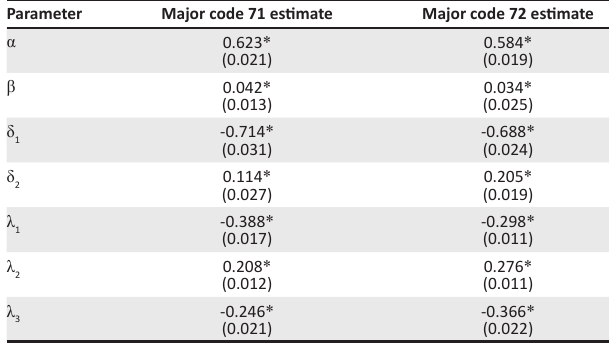
TABLE 3: Estimation results of the additive multivariate regression analysis.